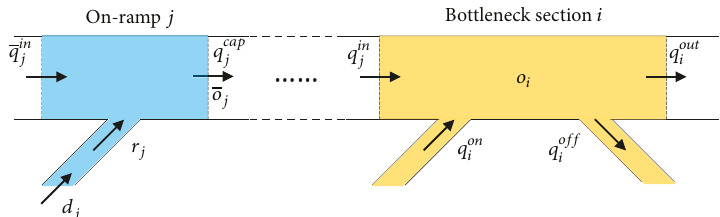
Figure 1: Ramp metering variables of bottleneck section 𝑖 and on-ramp 𝑗